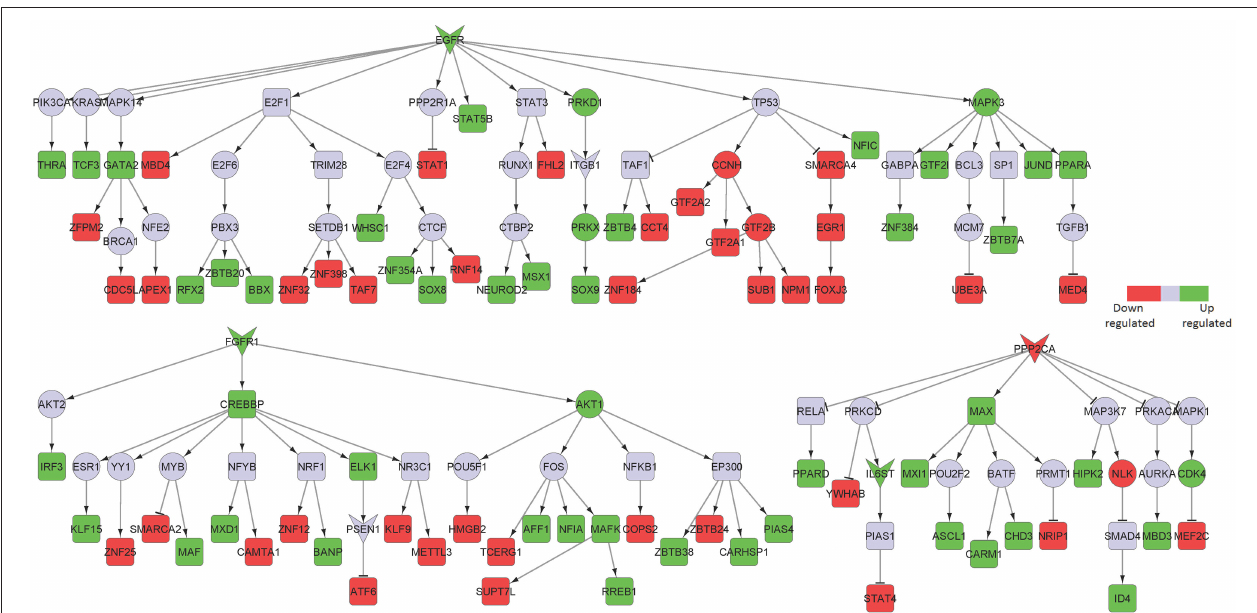
FIGURE 6 | Key signaling networks identified for the primary visual cortex. The figure shows three signaling subnetworks controlled by EGFR, FGFR, and PPP2CA for the primary visual cortex with known role in AD. EGFR signaling subnetwork was found to regulate 20 up- and 21 downregulated TFs, FGFR signaling subnetwork was found to regulate 13 up- and 12 downregulated TFs, and PPP2CA signaling subnetwork was found to regulate 9 up- and 4 downregulated TFs. Further, EGFR and FGFR1 subnetworks were found to be constantly activated while PPP2CA signaling subnetwork was constantly inhibited. The figure legends are the same as that in Figure 2 . Supplementary Figure 5 contains the other subnetworks identified for primary visual cortex that did not have known role in